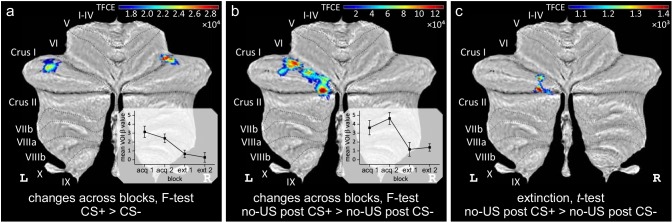
Changes in differential cerebellar activation across acquisition and extinction blocks based on F-tests.(a) Related to the prediction of the US (contrast ‘CS+ > CS-‘), and (b) related to the omission of the US (contrast ‘no-US CS+ > no US CS-") [p<0.05 FWE corrected, using TFCE; http://dbm.neuro.uni-jena.de/tfce/]. Mean β values across blocks are shown in the inserts. Note that all no-US CS+ trials were considered as a single block which was compared first against the early and then against the late ‘no-US post CS-’ block. (c) Cerebellar activation during extinction trials considering the contrast ‘no-US CS+ > no US post CS-’ (p<0.05 FWE corrected, TFCE). CS = conditioned stimulus; FWE = familywise error; TFCE = threshold-free cluster-enhancement; US = unconditioned stimulus.